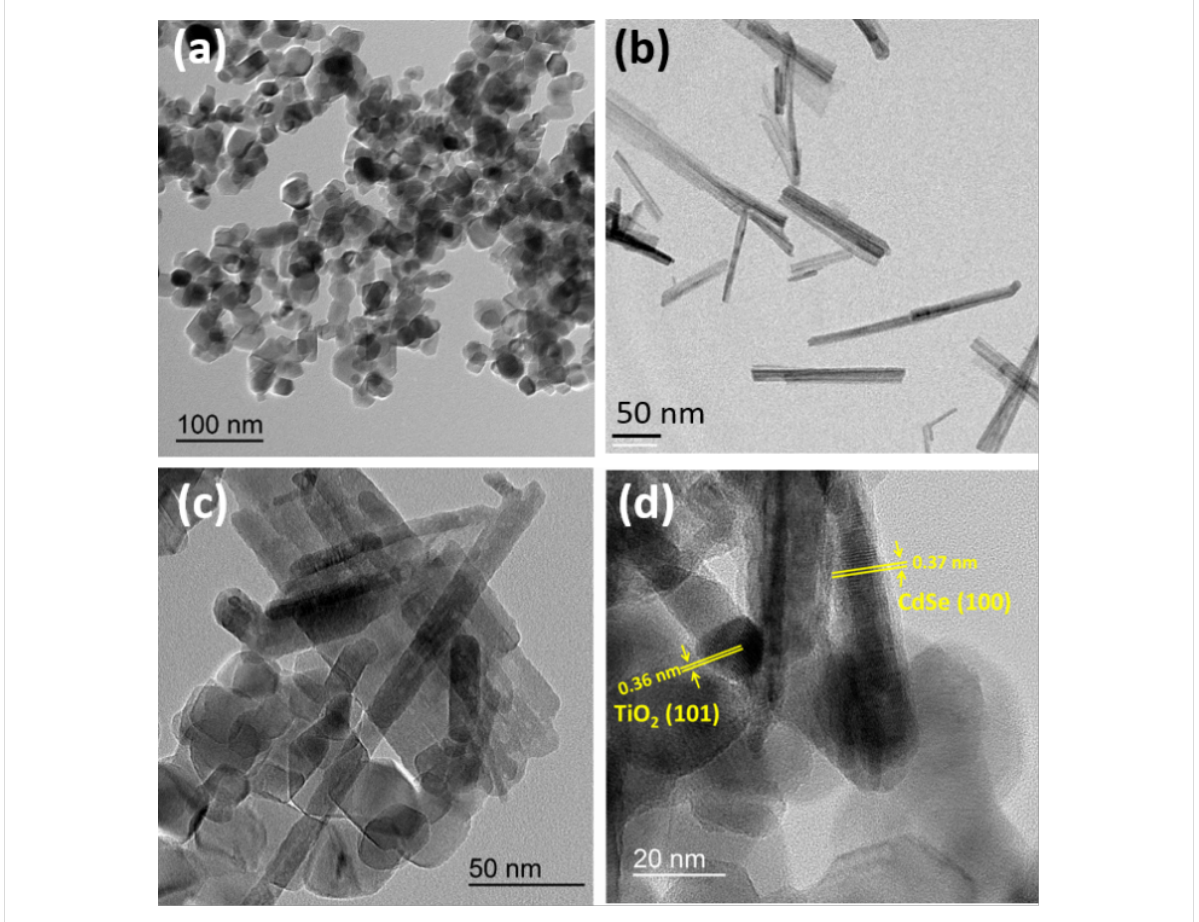
Figure 1: TEM images of (a) TiO 2 , (b) CdSe nanorods and (c) the CdSe (2 wt %)/TiO 2 composite. (d) HR-TEM image of CdSe nanorods associated to TiO 2